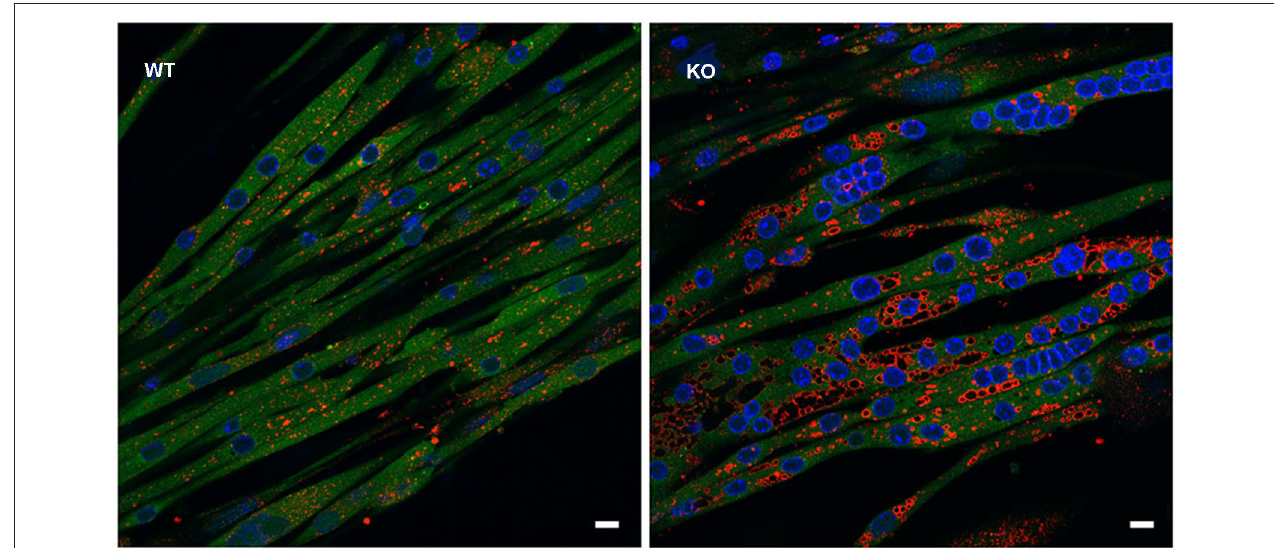
from mice generated by crosses of GFP-LC3:GAA-KO to Immortomice. LC3 (green) is a specific autophagosomal marker. No autophagosomal accumulation is seen in the GAA-KO cells. Myotubes were fixed and stained for lysosomal marker LAMP1 (red). Enlarged lysosomes are seen in the GAA-KO, but not in control WT muscle cells. Bars: 10 µ